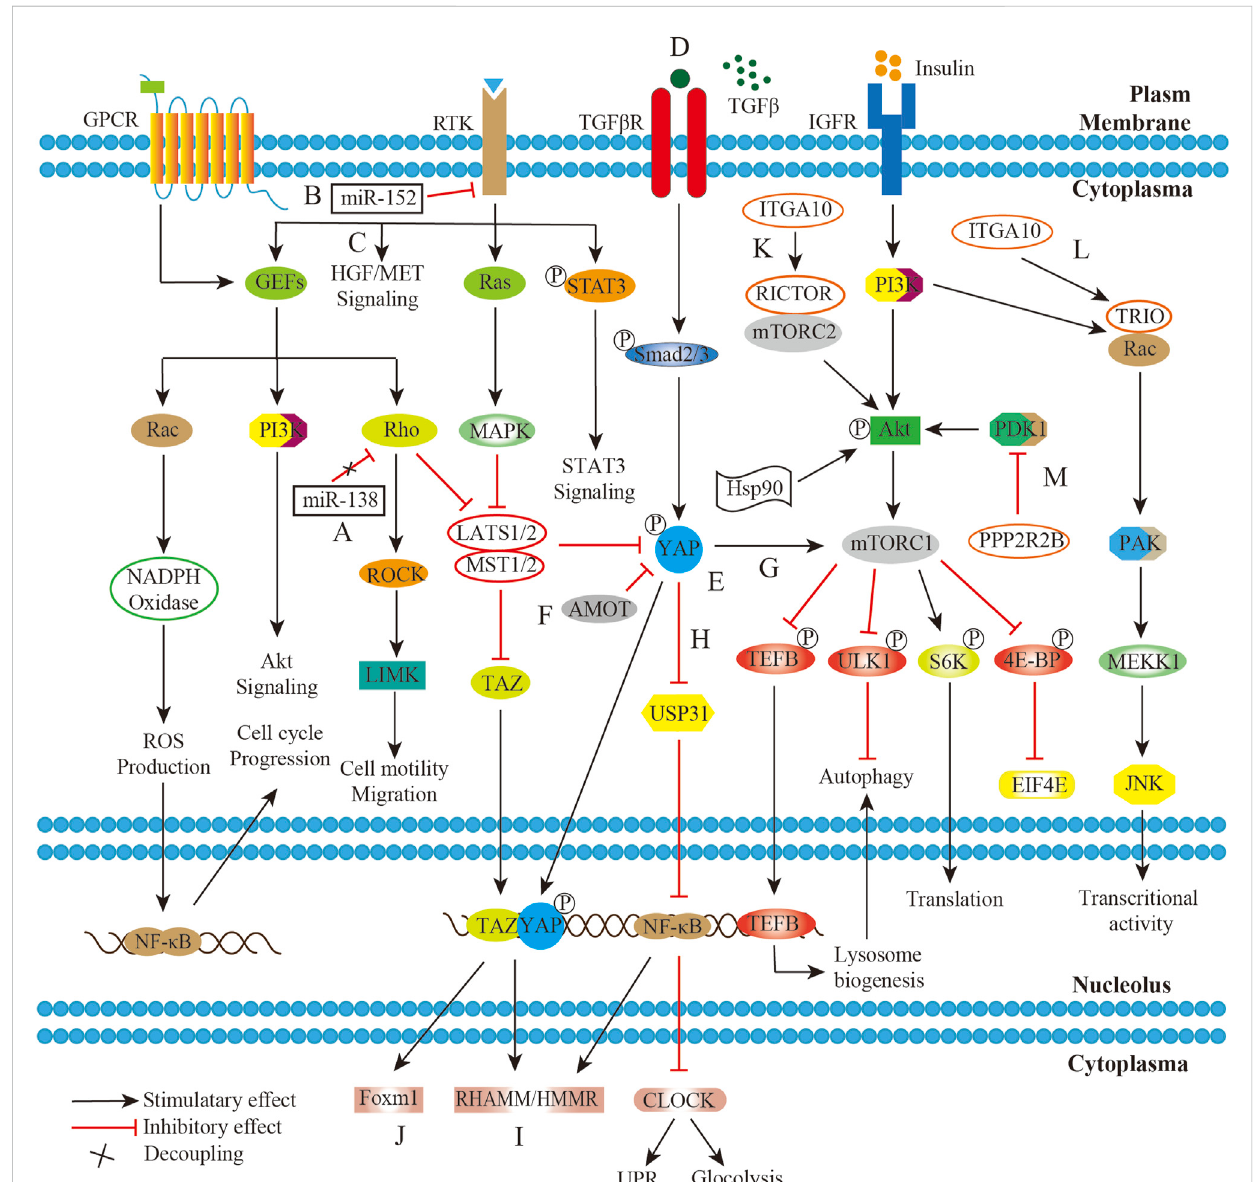
FIGURE 2 Working model of con fl uent network summarizing GPCR/Rho/ROCK, RTK/Ras/MAPK, TGF β /YAP/NF- κ B/mTOR, IGFR/PI3K/mTOR, and HGF/MET pathways in UPS/MFS. (A) . The decoupling of miR-138 from RHO-ROCK adhesion pathway promotes UPS cell migration; (B) . miR-152 downexpression disinhibits target genes production with receptor tyrosine kinase activity, and thus upregulates the downstream MAPK signaling; (C) . Hepatocyte growth factor/MET (HGF/MET) pathway was aberrantly activated due to its receptor overexpression. (D) . The signi fi cant secretion of TGF β cytokine by tumor-in fi ltrating macrophages (TAMs) in the sarcoma microenvironment activates downstream signaling; (E) . Yes-associated protein (YAP) is constitutivelyactivatedbyupstreampathwaysincludingTGF β pathway; (F) .TAZandYAParenormallyinhibitedbyHippopathwayorAngiomotin(AMOT), but unusually stable in UPS/MFS; (G) . YAP activates mTOR signaling, exhibiting NF- κ B independent effect of on autophagy; (H) . YAP controls the expression ofubiquitinspeci fi c protein 31(USP31),and thus phosphorylated NF- κ Bpersistently suppresses thecircadian clockactivity,leading to cellular metabolism shift and unfold protein response (UPR) dysfunction; (I) . Stabilized YAP and TGF β signaling cooperatively regulate hyaluronan-mediated motility receptor (RHAMM/HMMR) expression, enhancing sarcomagenesisand distantmetastasis; (J) . The complex between transcriptionalco-activator with PDZ-binding motif (TAZ) and YAP translocate into the nucleus and upregulate FOXM1 expression, which is pro-growth factor in UPS/MFS; (K) . The transcriptional product of ITAG10 is associated with RICTOR which is subunit of rapamycin complex 2 (mTORC2); (L) . ITAG10 encodes TRIO, and promote cell survival via RAC/PAK signaling; (M) . PPP2R2B encoding product directly interacts with PDK1 and suppresses AKT/mTOR signaling in